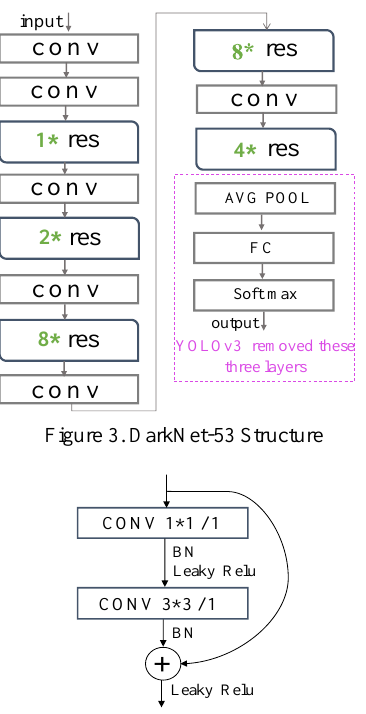
Figure 4. Residual block structure